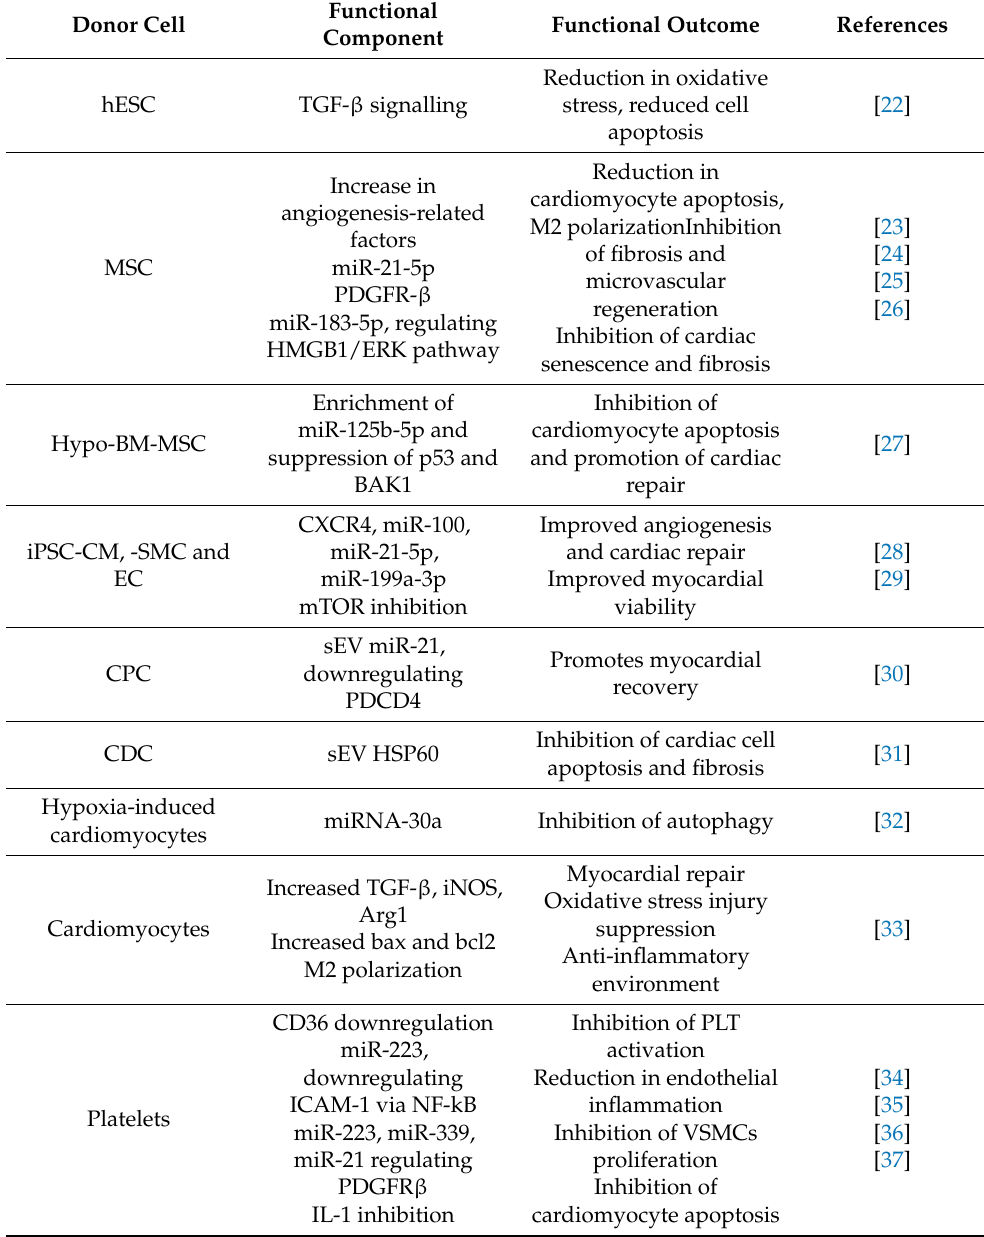
Table 1. Studies demonstrating the various sEV sources and the respective cardioprotective effect and mechanism of